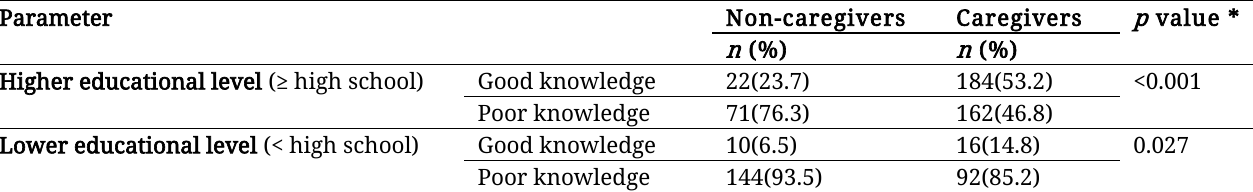
Table 5: Comparing overall knowledge between non-caregivers and caregivers according to education level